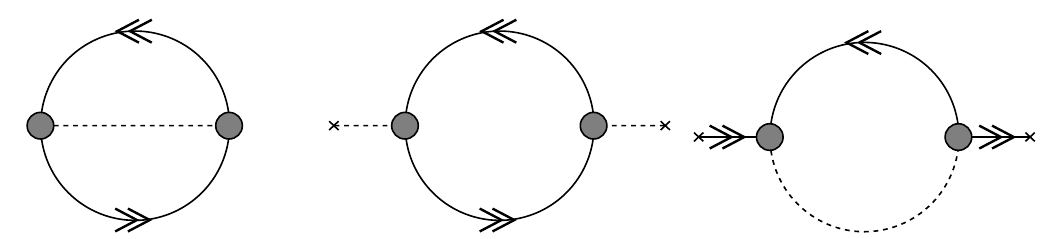
Figure 11. The Φ functional (left panel) for the case of mesons in quark matter, where the bosonic meson propagator is defined by the dashed line and the fermionic quark propagators are shown by the solid lines with arrows. The corresponding meson and quark selfenergies are shown in the middle and right panels,